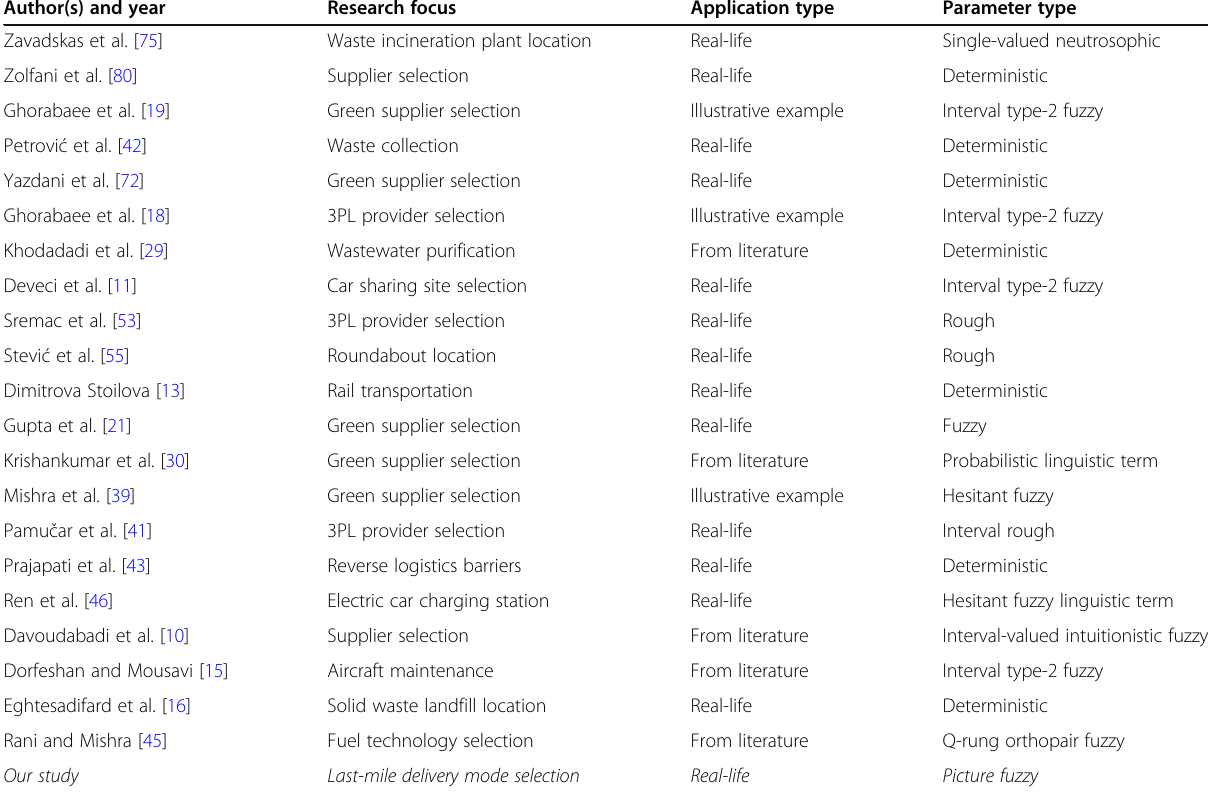
Table 2 Summary of the available applications of the WASPAS method Author(s) and